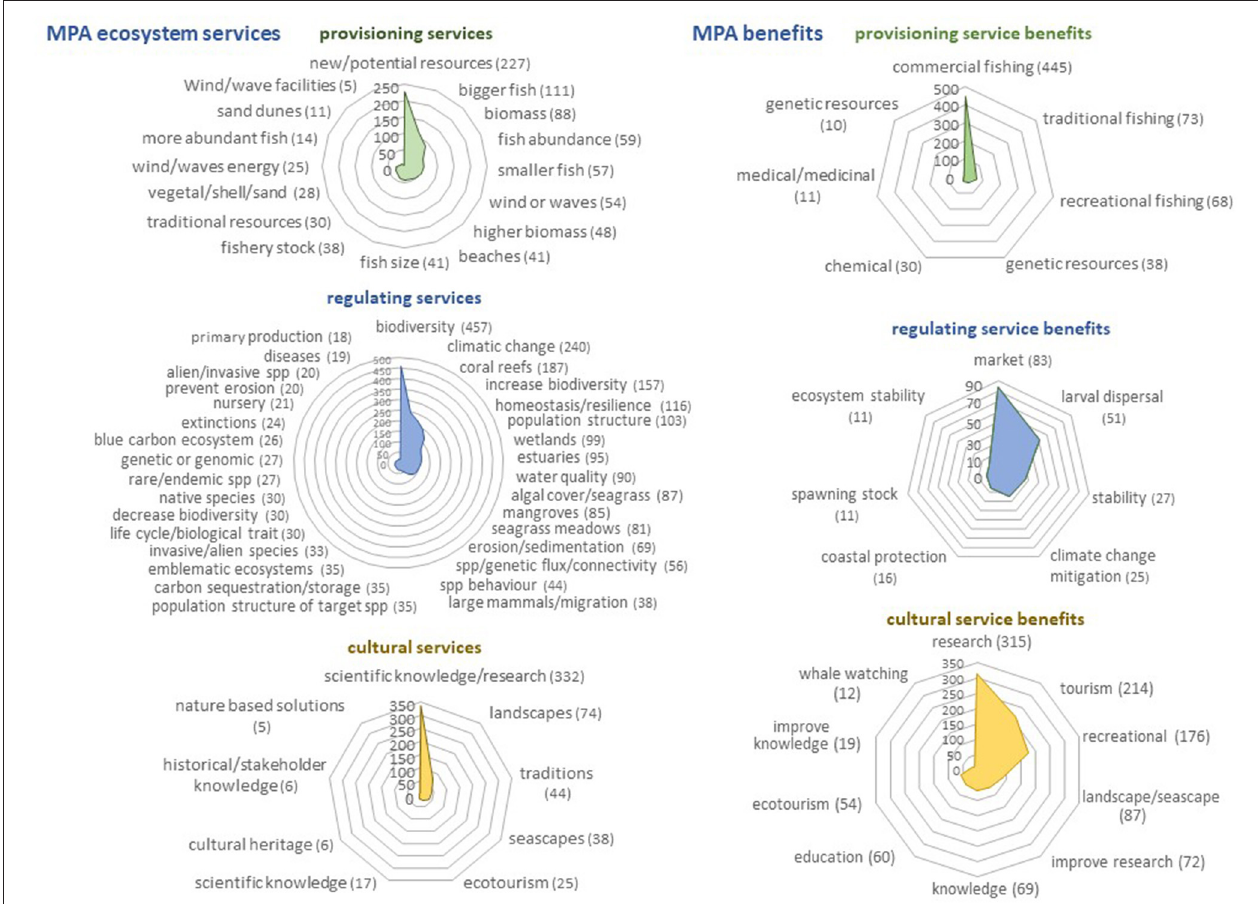
FIGURE 5 | Graphic representation of the occurrence (number of articles) of main Ecosystem services and societal benefits produced by MPAs according to the articles recorded in the Web of Science. Only search terms exceeding 1% of the total number of articles including the terms “service” and “benefit”, respectively, are